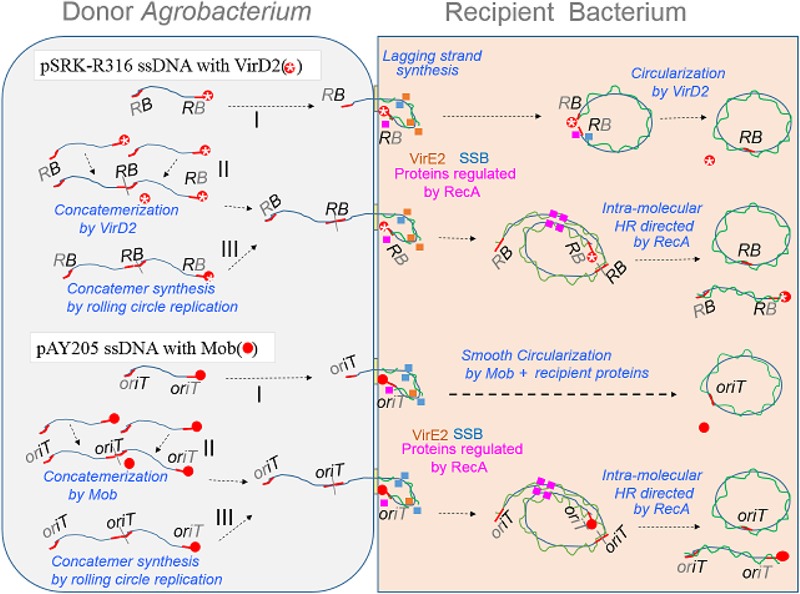
Schematic models of AMT of bacteria with an emphasis on the DNA structure of transfer intermediates, relaxase and ssDNA binding proteins (SSB and VirE2). ssDNA covalently linked with a relaxase protein, either Mob (filled red circle) or VirD2 (red circle marked with a star), is formed by the action of the relaxase on its target plasmid DNA. Rolling circle replication produces a monomer (I) molecule with a relaxase at each 5′-terminus. The nucleoprotein is mobilized via a VirB/D4 channel to a recipient bacterium. Upon entry of the nucleoprotein molecule, DNA polymerase starts lagging strand synthesis. Simultaneously, ssDNA portions are bound by ssDNA binding proteins, namely VirE2 from the donor, recipient SSB, RecA and proteins whose expression is enhanced by RecA. Mob catalyzes re-circularization at high efficiency, while VirD2 re-circularizes less efficiently in the recipient bacterial cell. The nucleoprotein molecule in the donor cell can also participate in another process that was previously proposed for yeast AMT (Rolloos et al., 2014). Two molecules are merged to form a concatemer linked with a relaxase (II); this reaction releases a relaxase molecule. Rolling circle replication sometimes produces a concatemer (III) molecule having a relaxase at each 5’-terminus. The concatemers (II,III) enter the recipient bacterium and finally produce monomeric circles through HR directed by RecA.